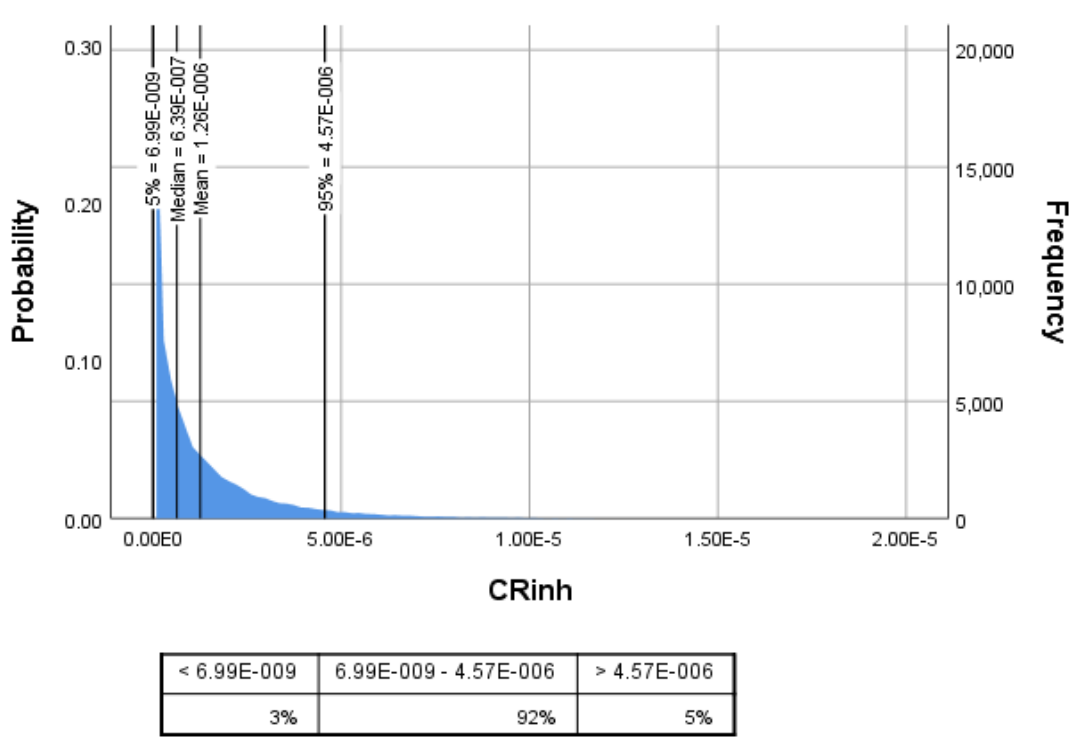
Figure 3. Inhalation cancer risk resulting from personal exposure to DEHP (CR inh ) and estimated exposure to DEHP (CR inh_estimated ) using the time-weighted model. Note: 1.0E-06 = 1.0 × 10 − 6 . The DEHP exposure concentrations and CSF value variability could result in uncer- tainty in health risk estimations. For example, if we consider the CSF value of 0.014 (mg/kg·day) − 1 from the IRIS database, the potential cancer risks would be one order of magnitude higher (i.e., 2.0 × 10 − 5 and 2.1 × 10 − 5 ) than the acceptable risk level. Our results exemplify the potential carcinogenic effects of DEHP on human health, suggesting that